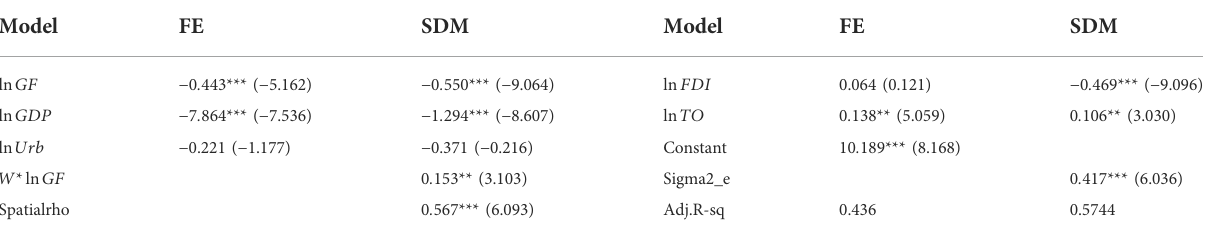
TABLE 4 Green fi nance and industrial pollution.